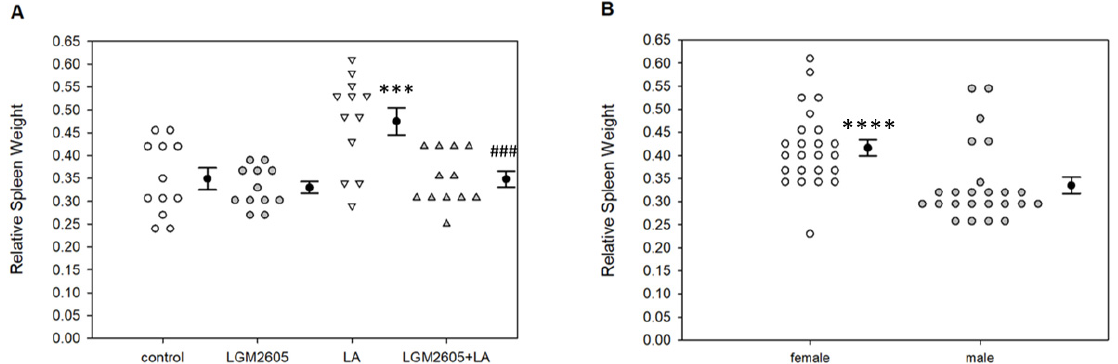
Figure 2. Spleen weight analysis. Relative spleen weights were determined by dividing raw spleen weights by individual mouse body weights. ( A ) LA treatment significantly increased relative spleen weights compared to saline control, *** p = 0.001; LGM2605 + LA treatment reduced relative spleen weights back to control levels, ### p < 0.001. Following two-way ANOVA, data were analyzed via Tukey post-hoc test. The observed patterns were consistent with sex; however, female mice demonstrated significantly higher relative spleen weights compared to males ( B ), **** p < 0.0001 by one-way ANOVA.